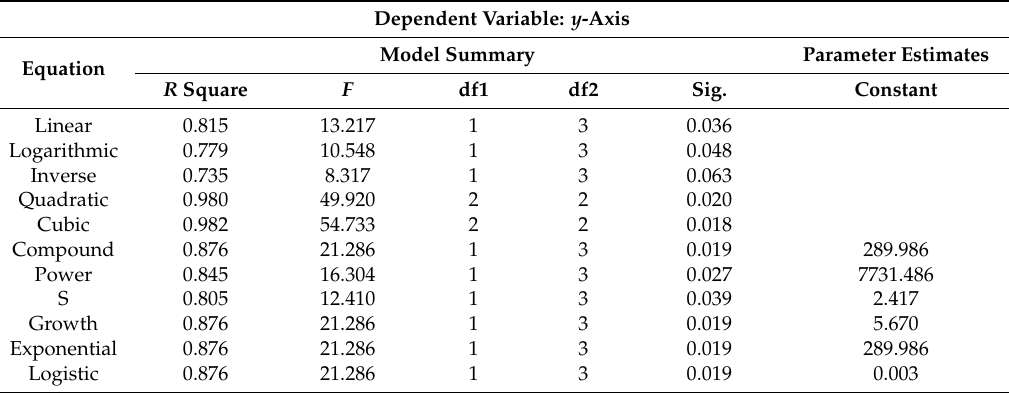
Table A5. Model summary and parameter estimates.